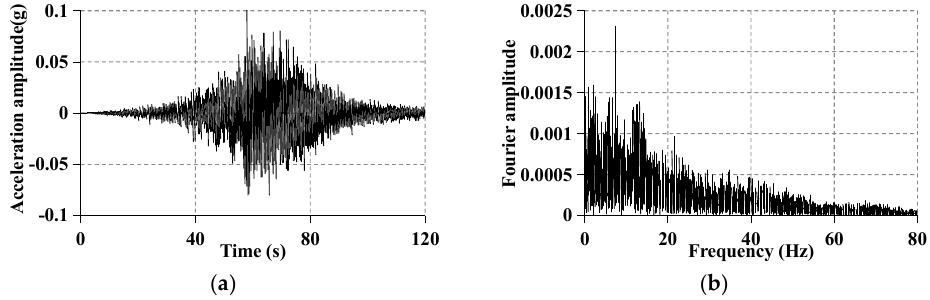
Figure 7. The input WE wave (0.08 g): ( a ) Time history, ( b ) Fourier spectrum.